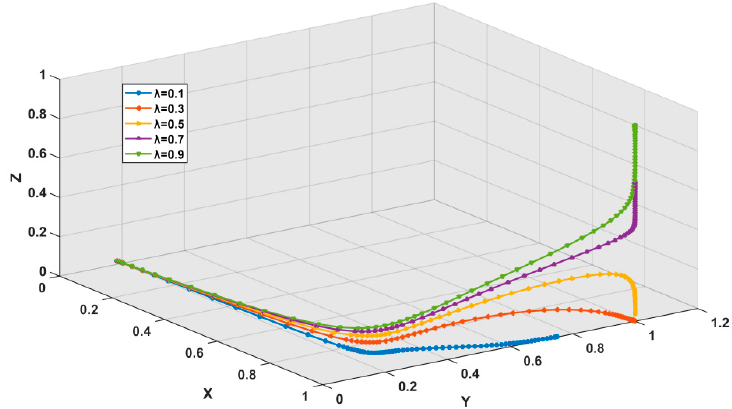
Figure 5. The influence of the change of λ on the system’s evolution trajectory.